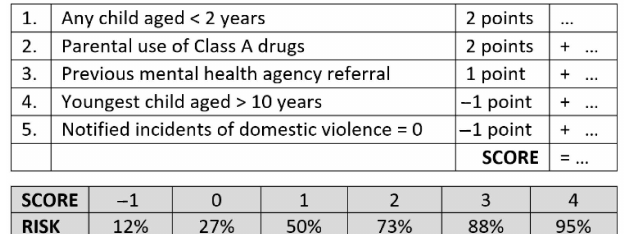
Figure 3. Example of an optimised scoring system for predicting re-referral to children’s services within 24 months (based on Rudun and Ustin